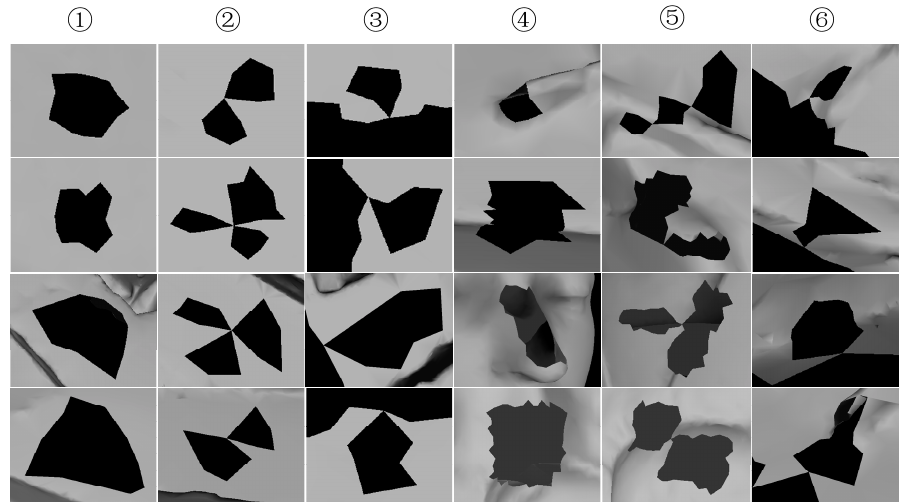
Figure 2. Different types of holes: 1 (cid:13) simple holes on flat surface, 2 (cid:13) complex holes on flat surface, 3 (cid:13) holes on a flat surface boundary, 4 (cid:13) simple holes on undulating surface, 5 (cid:13) complex holes on undulating surface, and 6 (cid:13) holes on an undulating surface